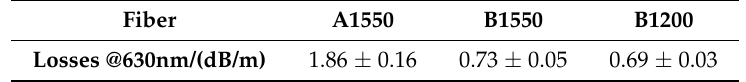
Table 3. Transmission losses of fibers derived from the sol-gel granulated silica